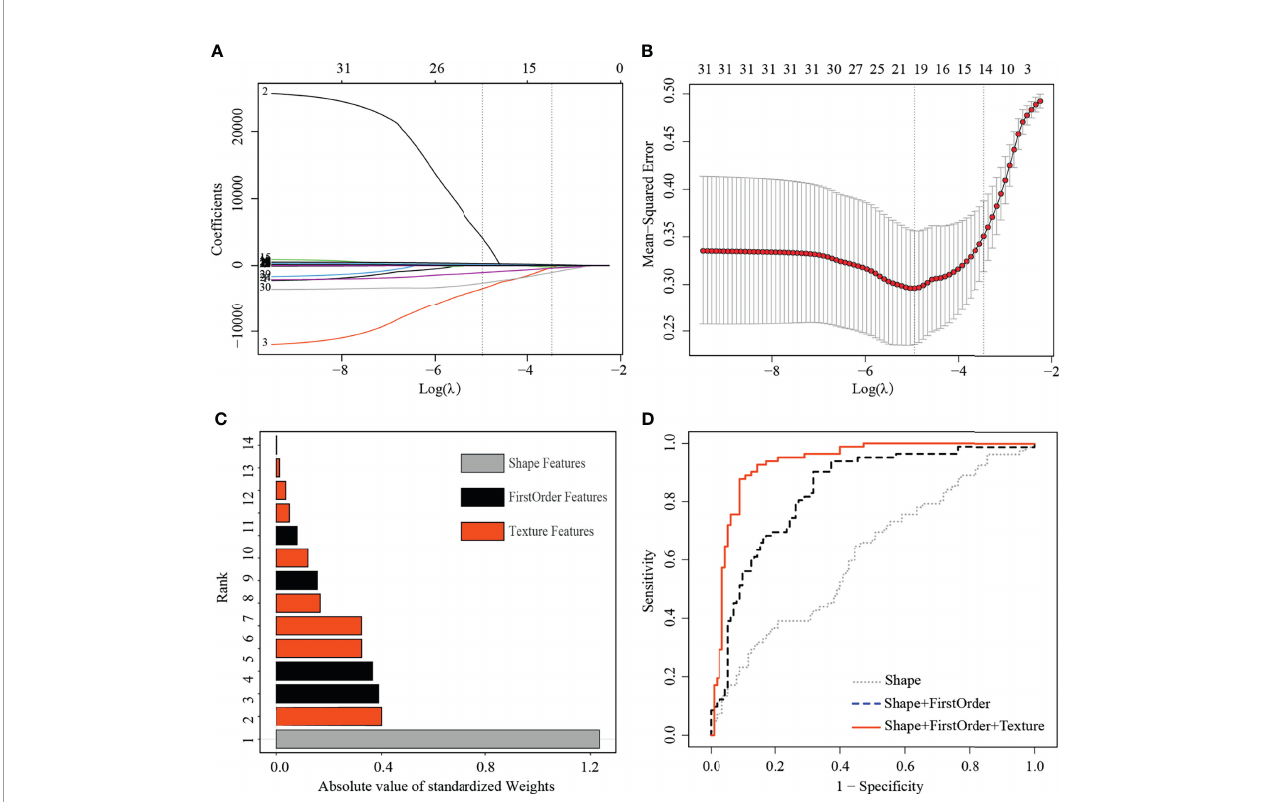
FIGURE 3 | Least absolute shrinkage and selection operator (LASSO) selection process, absolute values of weights, and receiver operating characteristic curves (ROC) of 14 useful radiomics features in training set. (A) LASSO coef fi cient pro fi les of the 32 non-redundant features. The y-axis represents coef fi cient of each feature. The optimal value of l was 0.0345, and the optimal log( l ) was − 3.37, resulting in 14 non-zero coef fi cients. (B) Mean square error path using tenfold cross- validation. (C) Absolute value of weights generated by the LASSO algorithms for the optimal log( l ) value. (D) The ROC curves for a combination of shape feature, fi rst order features, and texture